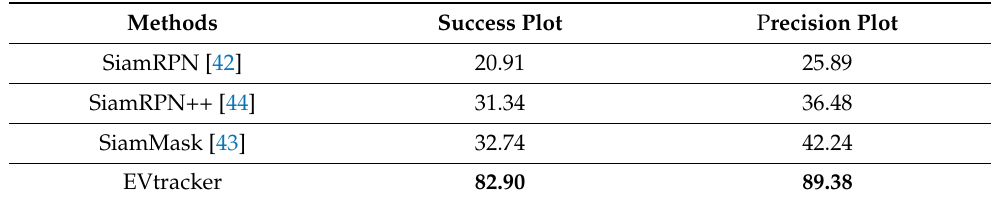
Table 4. Comparison to recent SOTA algorithms using the Success Plot metric and Precision Plot met- ric, and the best results are highlighted bold-faced.